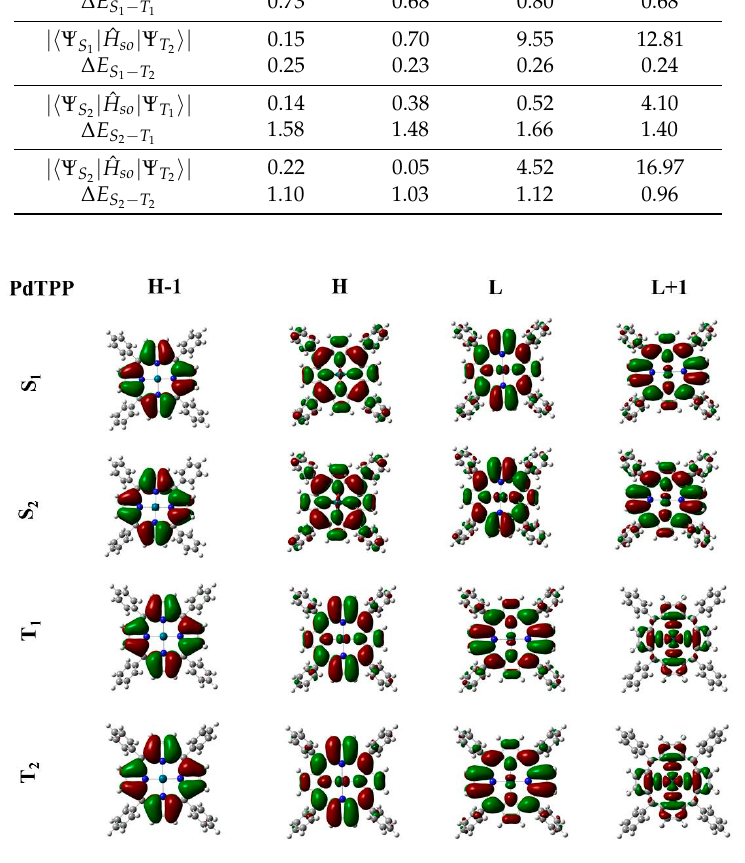
eV) between the involved excited states (cid:3172) (cid:2879)(cid:2904) (cid:3171)